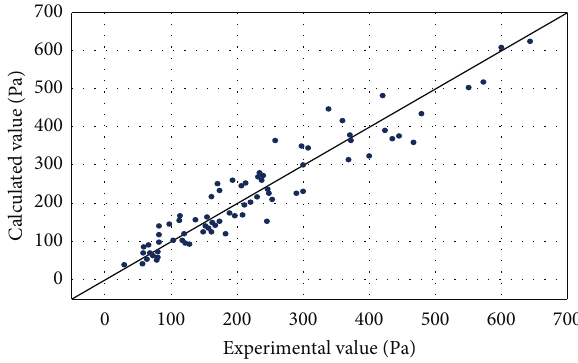
Figure 19: Comparison between calculated value and test